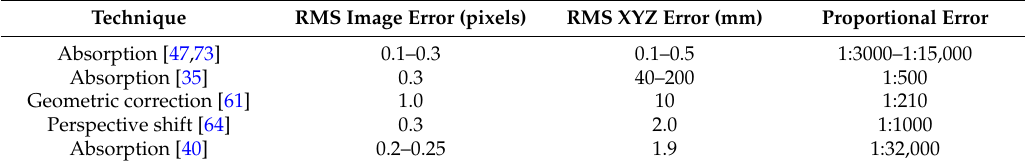
Table 2. A sample of some published results for the precision of underwater camera calibrations. Note that [35] used observations of a mobile fish pen and the measurements used by [61] were made to the nearest whole pixel.